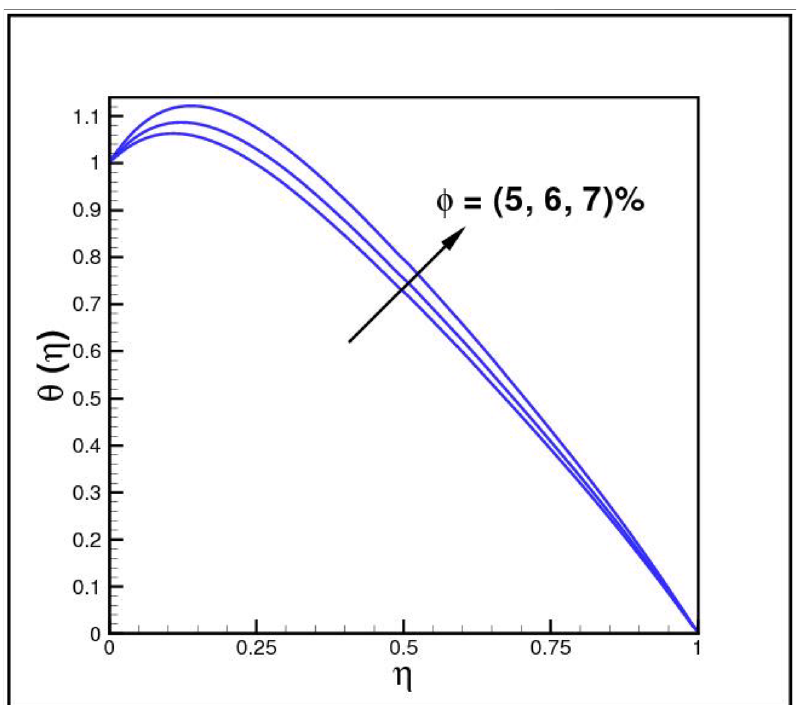
Figure 10. Impact of